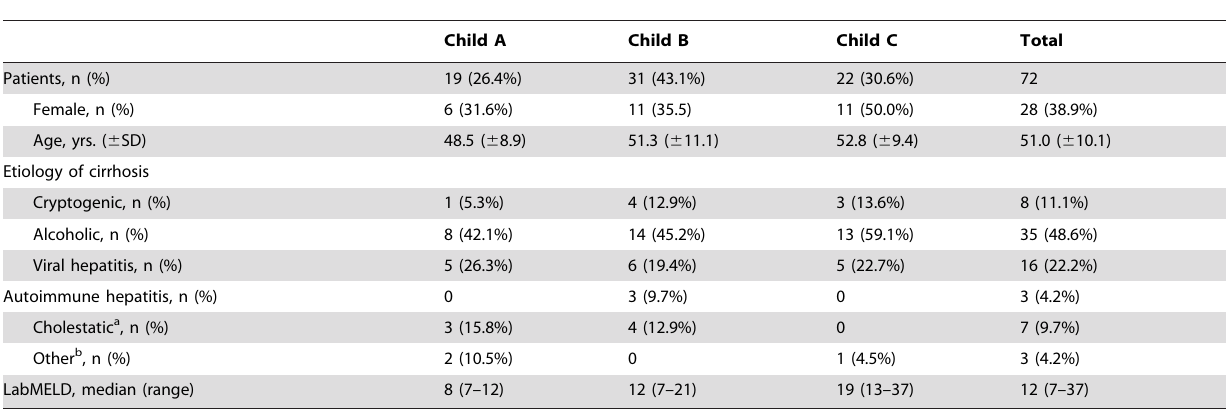
Table 1. Characteristics of patients with liver cirrhosis.